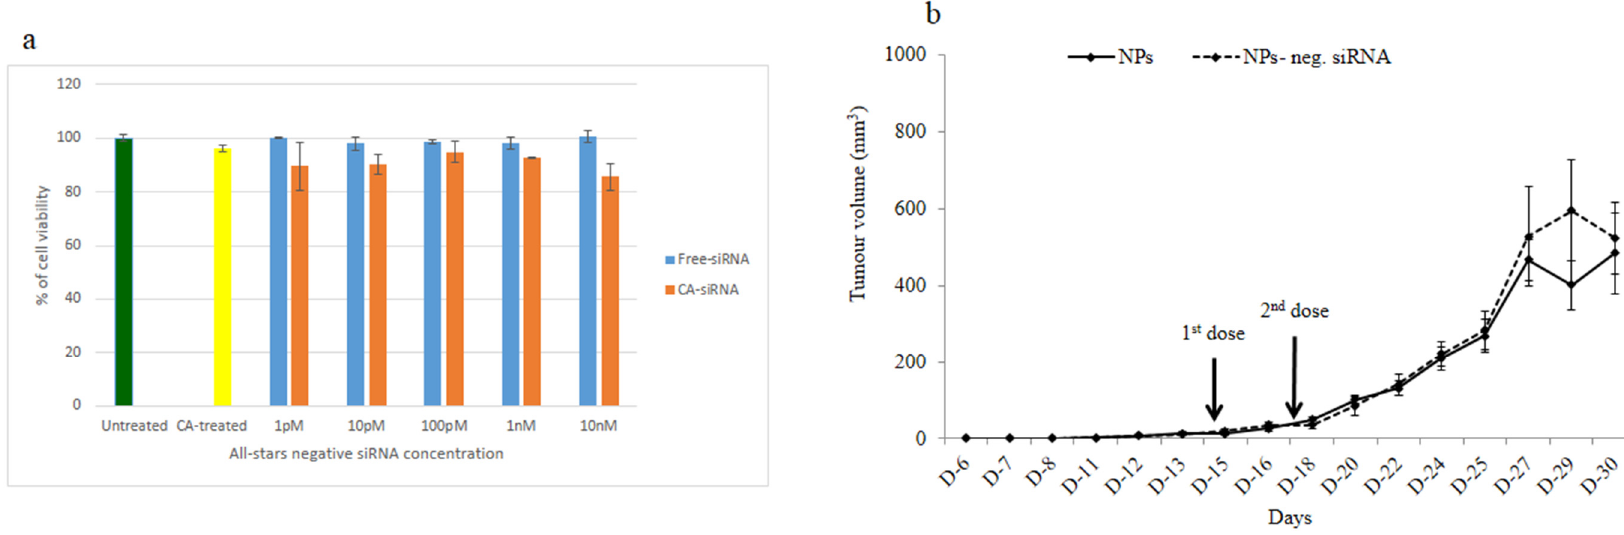
Figure 9. Effect of nanoparticles with loaded negative control siRNA on tumor outgrowth in 4T1 ‐ cells induced mouse model. ( a ) After formulation of CA nanoformulation of a negative control siRNA, MCF ‐ 7 cells were incubated with it for a consecutive period of 48 h and subsequently, MTT assay was carried out. Mice were treated intravenously through tail ‐ vein injection with 100 μ L of either nanoparticles or nanoparticles with electrostatically associated negative control siRNA (50 nM). ( b ) Six mice/group were used and data were represented as mean ± SD.